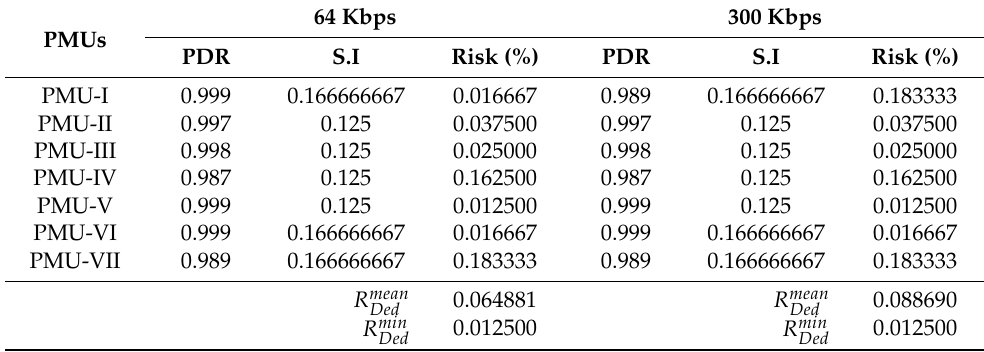
Table 3. Simulation results for dedicated SCN with 64 Kbps and 300 Kbps data rate. 64 PMUs